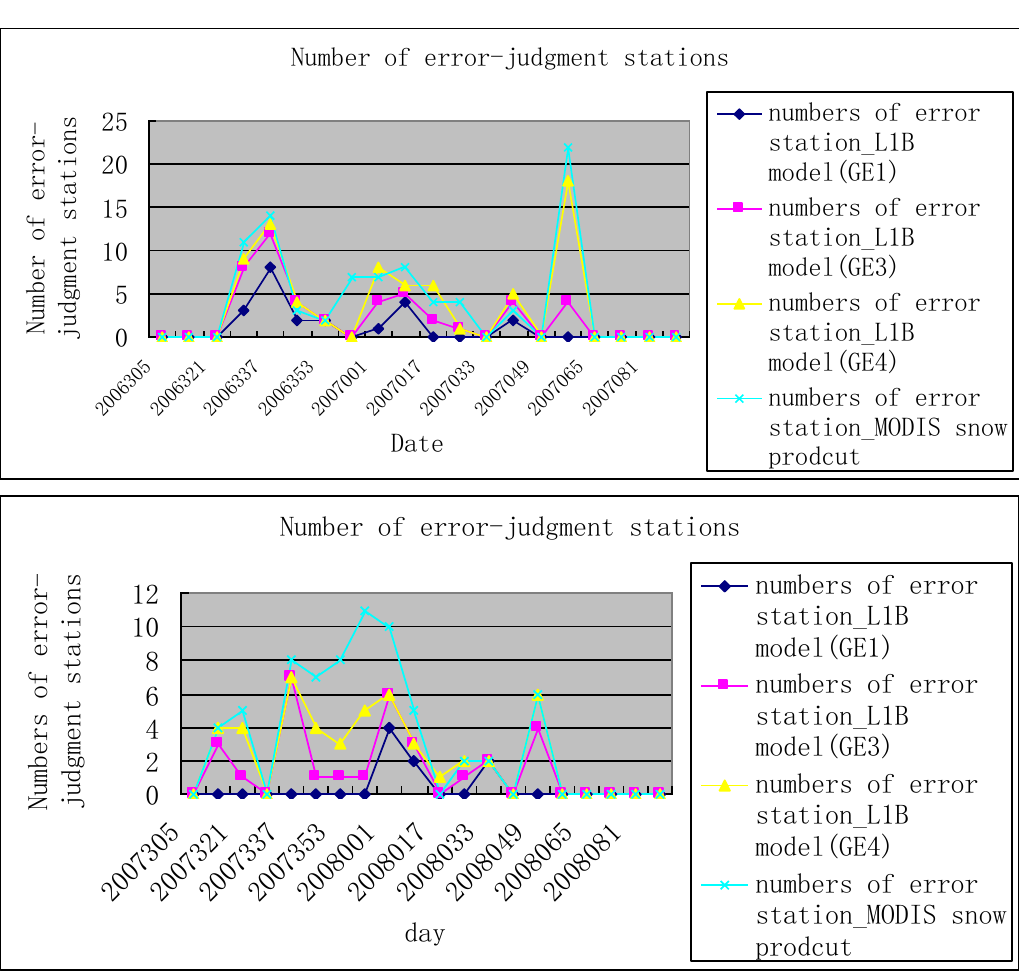
Figure 16. Numbers of error-judgment stations of the study model compared to MODIS Snow Products., for the 2006–2007 (upper) and 2007–2008 (lower)